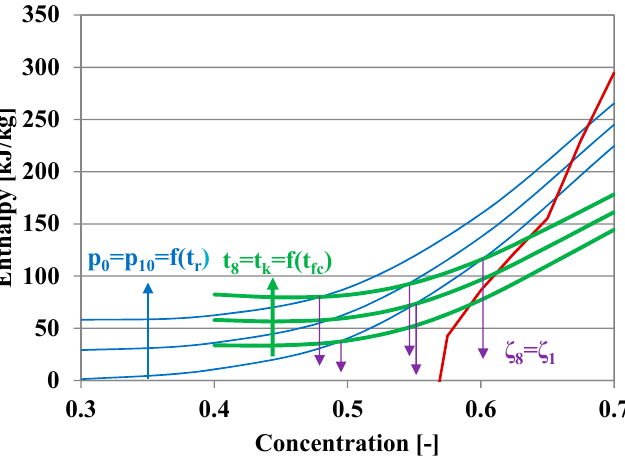
Figure 12. Influence of di ff erent parameters on the diluted solution concentration.